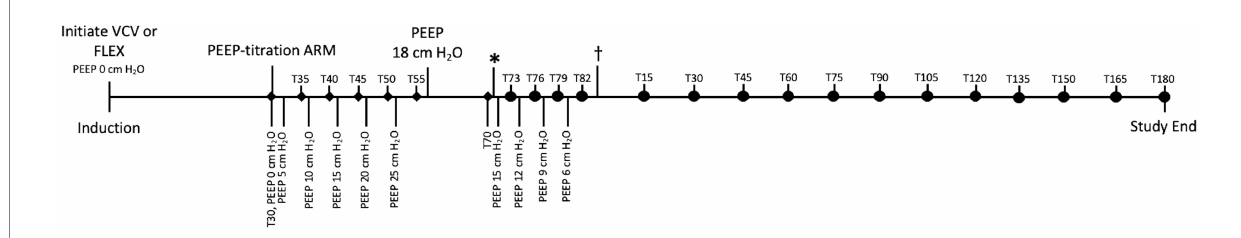
FIGURE 1 Timeline of study demonstrating sequence of events and timing of measurements. PEEP-titration alveolar recruitment maneuver (ARM) started 30 min after initiating ventilation (VCV or FLEX). During ARM, PEEP stepwise increased by 5 cmH 2 O every 5 min until 25 cmH 2 O reached. ♦ : Mean arterial pressure (MAP), pulmonary arterial pressure (PAP), central venous pressure (CVP), heart rate (HR), and PaO 2 measured and recorded just before PEEP adjusted. At completion of ARM, PEEP reduced to 18 cmH 2 O and maintained for 15 min. * : PEEP stepwise reduced by 3 cmH 2 O every 3 min until alveolar closure pressure identified as indicated by a 20% decrease in PaO 2 and C dyn . •: Indicates measurement and recording of MAP, PAP, CVP, HR, PaO 2 , and cardiac output (CO) just before each step of PEEP reduction. † : PEEP set at that which previously maintained PaO 2 and C dyn . Measurements continued every 15 min until study completion. T30 through T82 corresponds to datapoints recorded on Table 1. T15 marks beginning of dataset recorded on Table